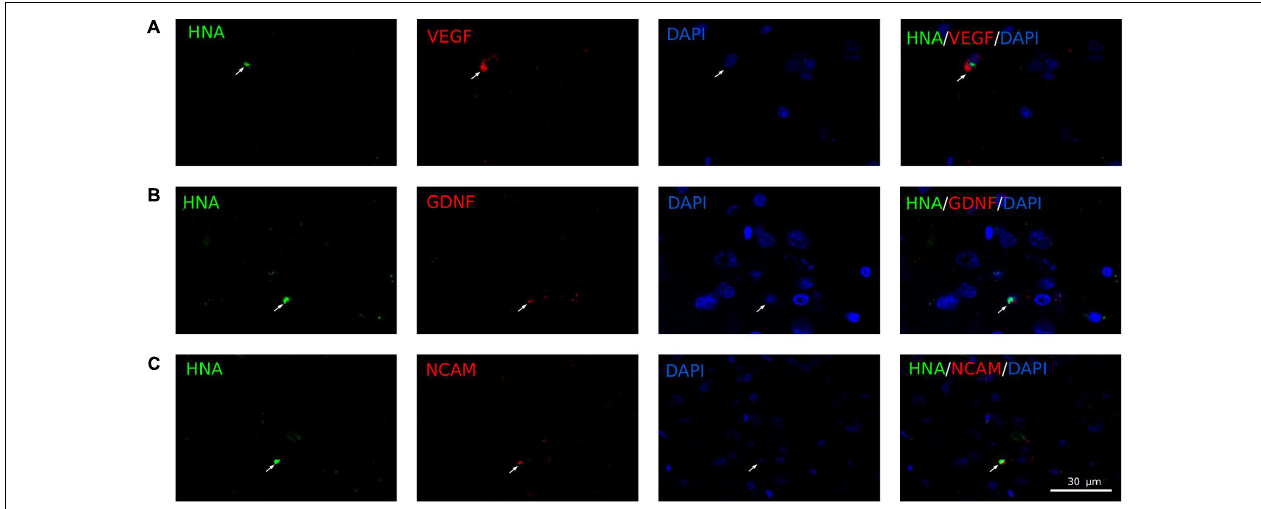
FIGURE 7 | Double immunofluorescent staining of UCB-MC in brain cortex 21 days after intrathecal infusion. Anti-human nuclear antigen (HNA) antibodies (Ab) were used for identification of UCB-MC, recombinant human proteins were identified with Ab against human specific VEGF, GDNF, and NCAM. (A) HNA immunopositive cells (green) expressing VEGF (red). (B) HNA immunopositive cells (green) expressing GDNF (red). (C) HNA immunopositive cells (green) expressing NCAM (red). Morphology of HNA immunopositive cells corresponds to the cord blood mononuclear cells with round nuclei surrounded by a thin rim of cytoplasm. Scale bar = 30 µ